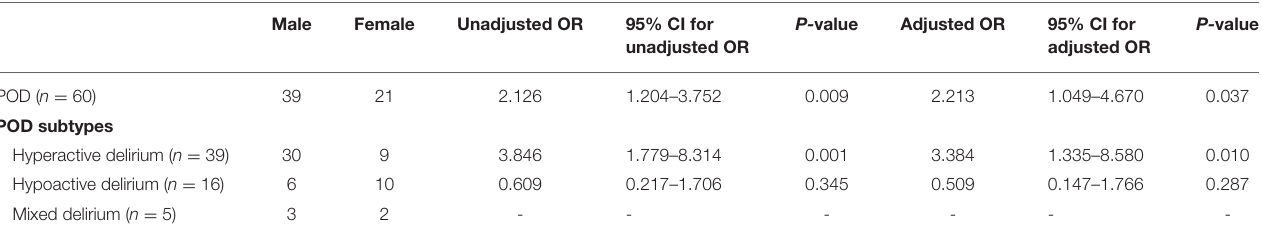
TABLE 3 | The logistic regression analysis of association between gender differences and occurrence of POD and its subtypes. Male